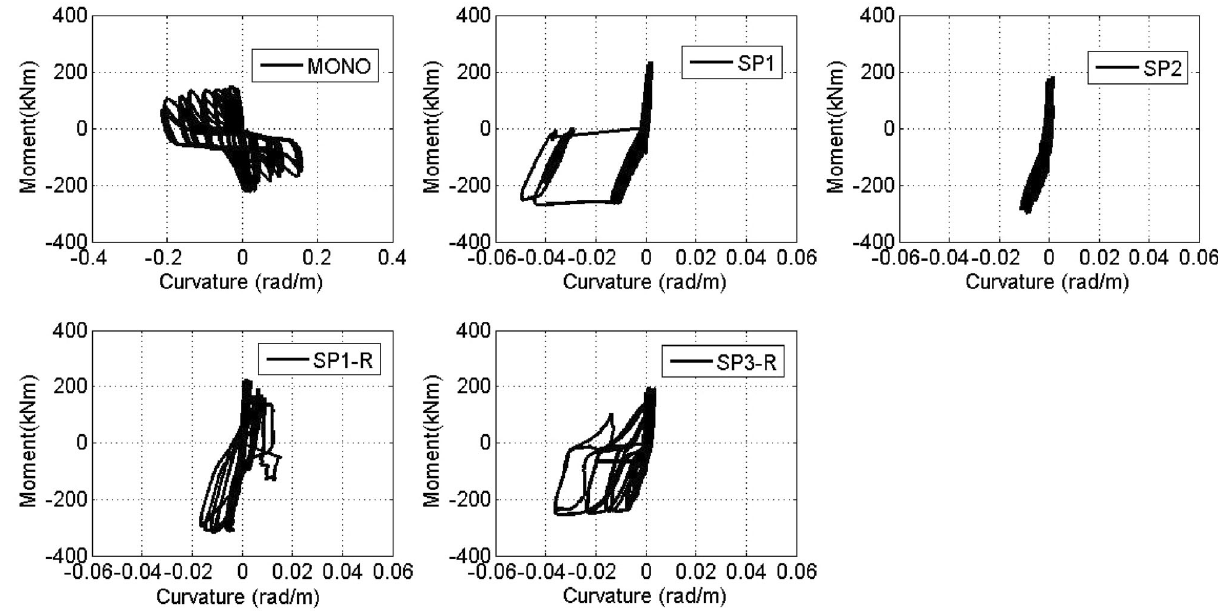
Fig. 17 Moment-curvature relationships of beam-column connection